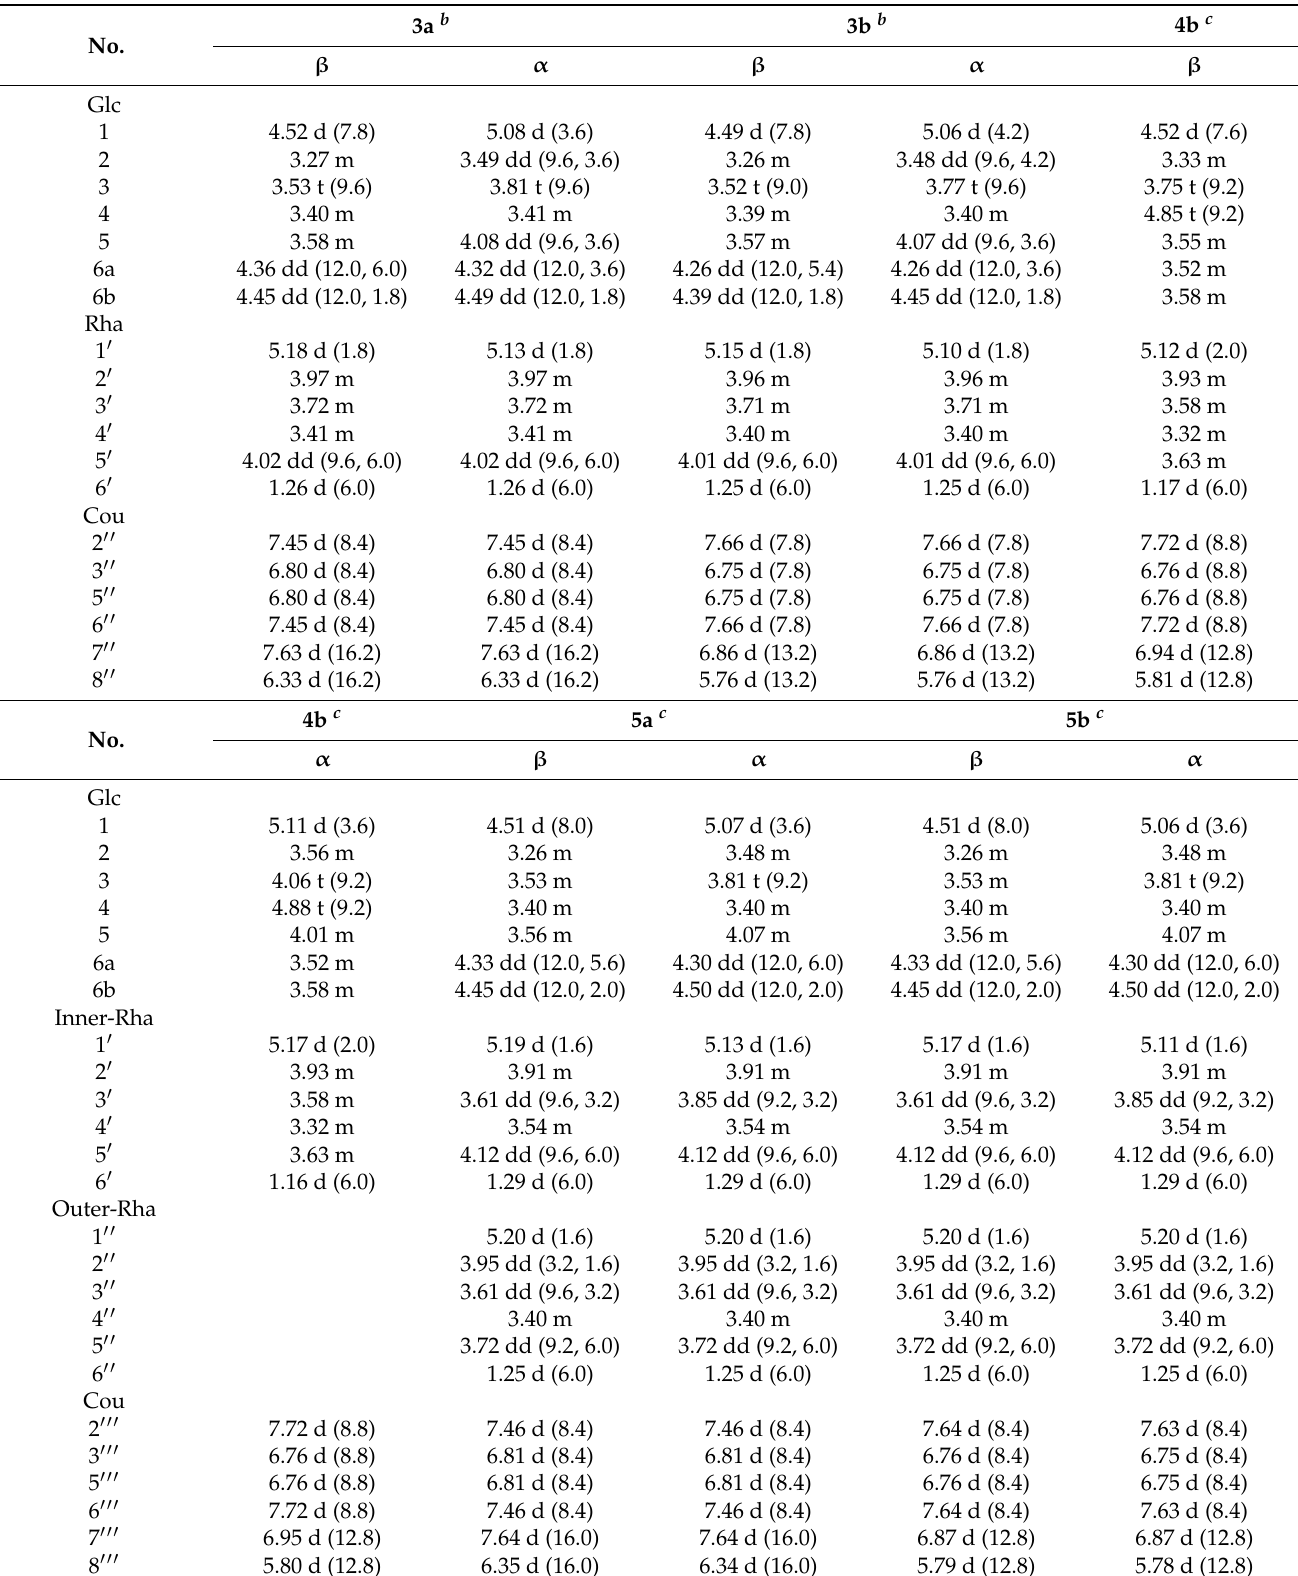
Table 3. 1 H NMR data of compounds 3 – 5 from L. robustum in CD 3 OD a